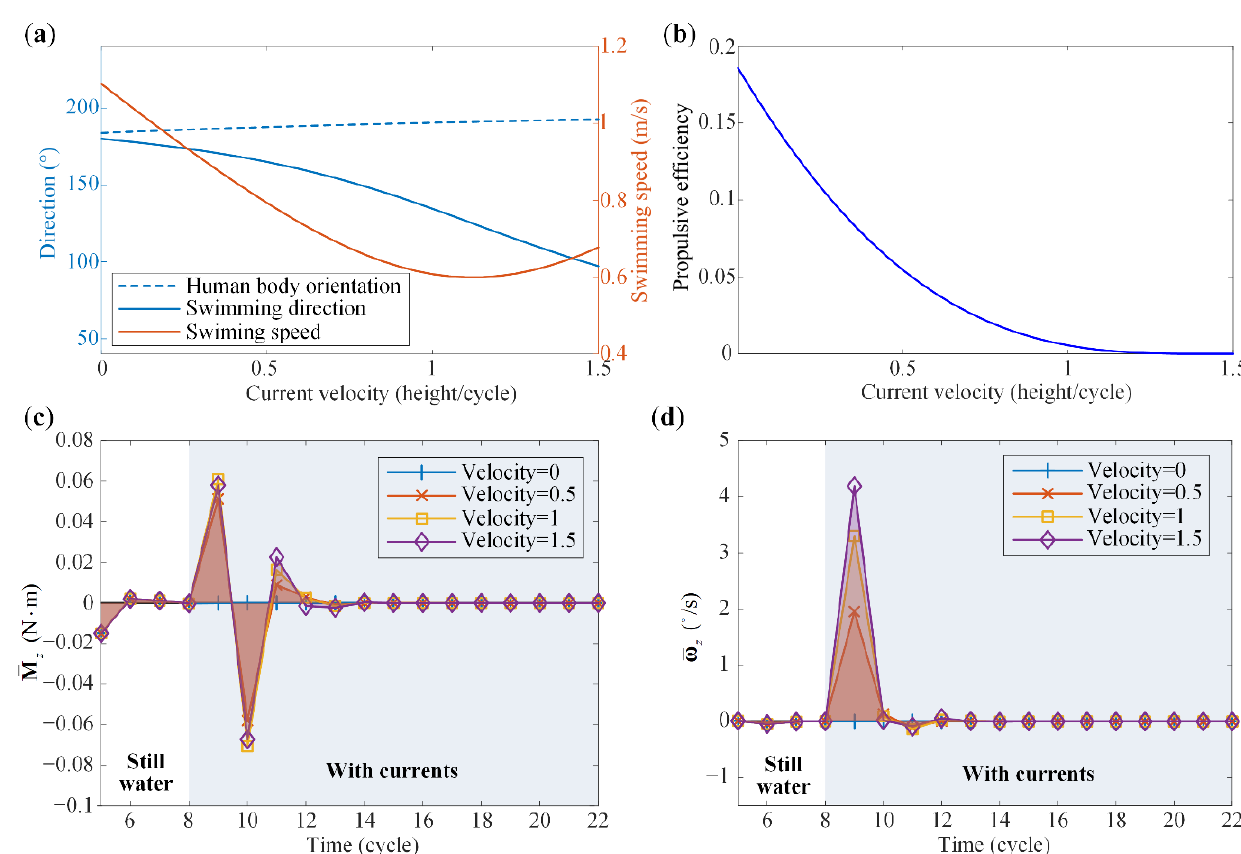
Figure 7. Analyses of the freestyle swimming performance under the 40 ° currents with variable velocity (Case I). ( a ) Evolution of the human body orientation, swimming direction, and swimming speed with respect to the current velocity. ( b ) Evolution of the propulsive efficiency with respect to the current velocity. ( c ) The average fluid moment per cycle applied to the human body about the global z axis ( M z ) at different current velocities. ( d ) The average angular velocity of the human body per cycle about the z axis ( ω z ) at different current